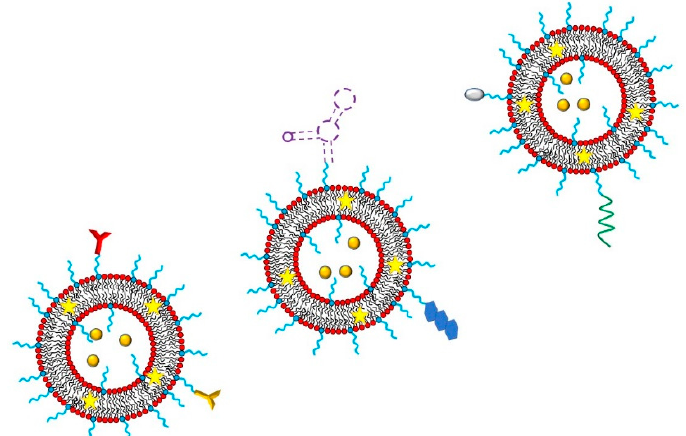
Figure 11. Schematic representation of targeted liposomes, with targeting ligands covalently linked to the distal end of PEG-lipids. For illustrative purposes, antibodies are shown on the left, aptamer and sugar in the middle, and a generic small molecule and peptide are sketched on the right.